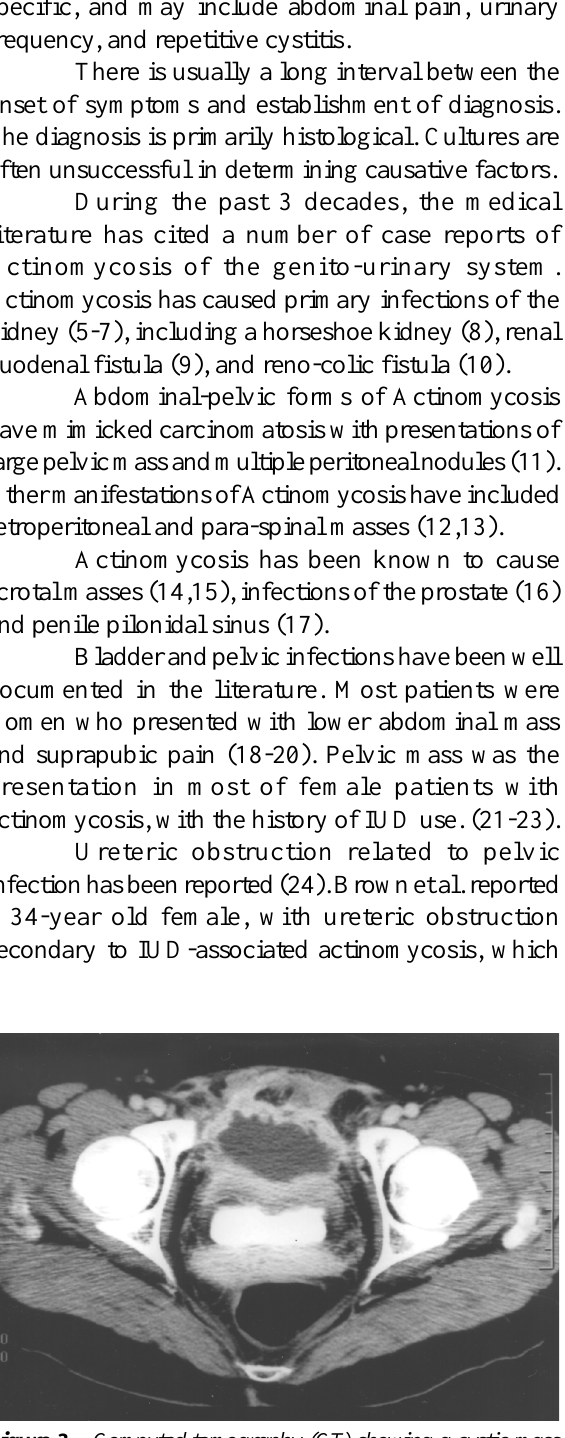
Figure 2 – Photomicrograph of chronic inflammation with multiple abscesses and clusters of Actinomyces (X400).